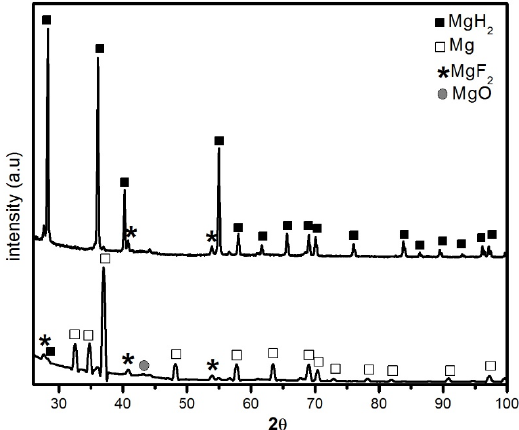
Figure 3. XRD patterns of MgH 2 + 5 mol% MgF 2 ( a ) after desorption at 335 °C under 100 kPa H 2 and ( b ) after re-hydrogenation at 335 °C under 1000 kPa H 2 .